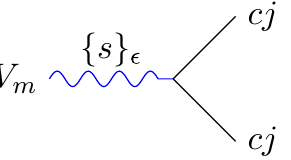
Fig. 1 Diagram related to . The s variable is the